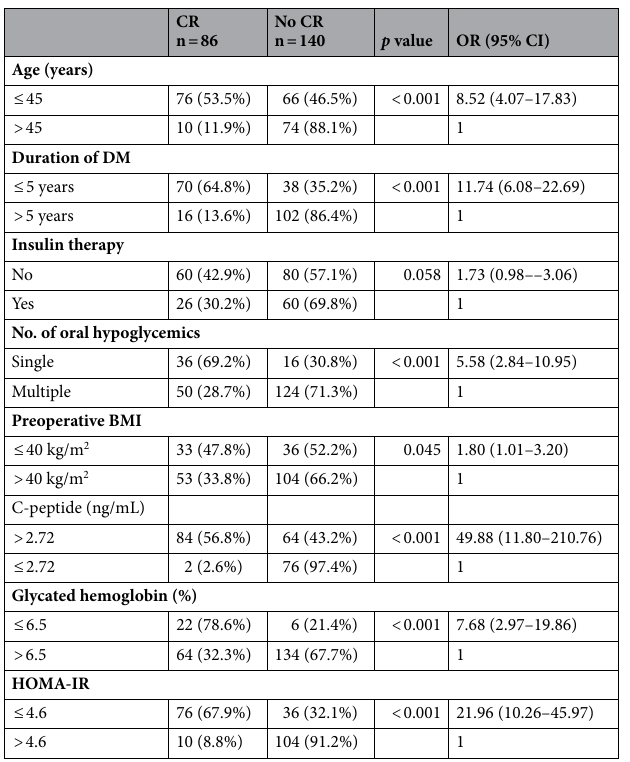
Table 5. Factors linked to complete remission of T2DM 2 years after LSG. OR odds ratio, CI confidence interval, CR complete remission, BMI body mass index, HOMA-IR homeostatic model assessment of insulin resistance.